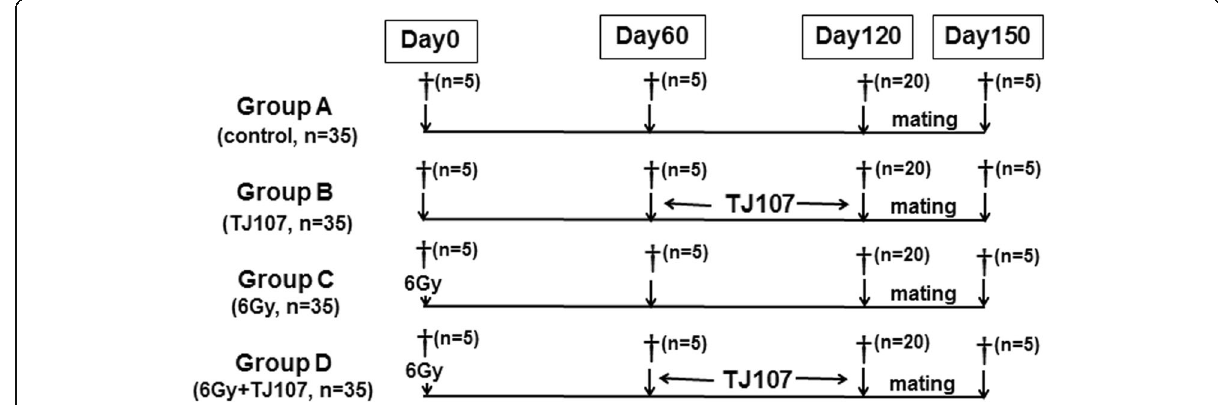
Fig. 1 Application of treatment as per the time schedule to the mice in each